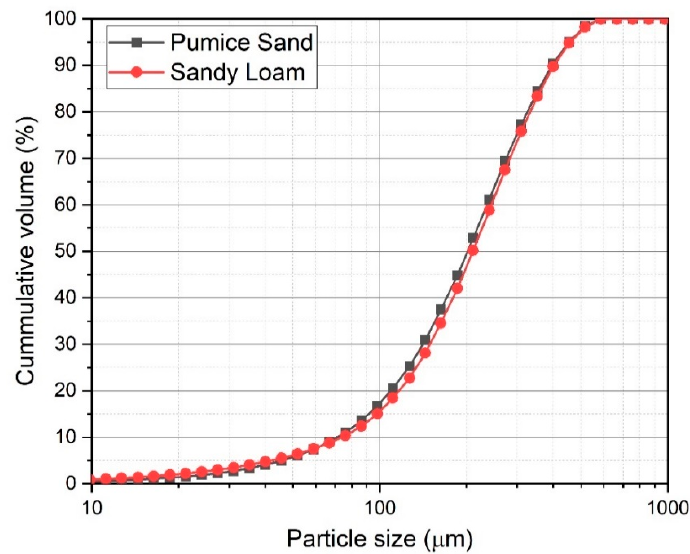
Figure 1. Particle size distribution of soil samples.